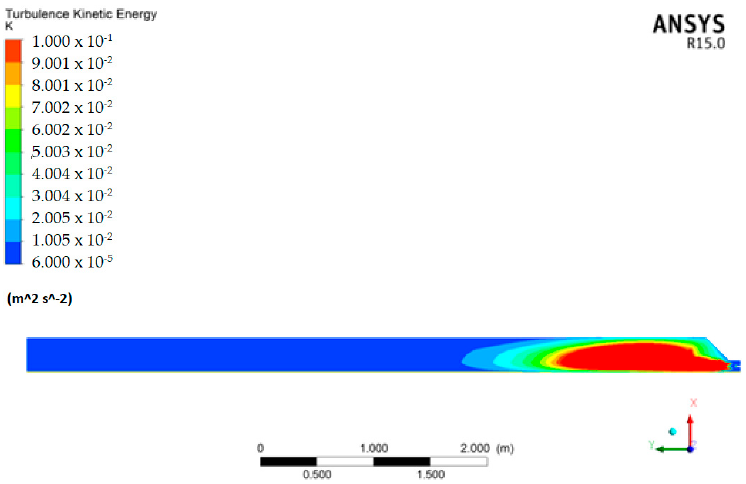
Figure 4. Turbulent kinetic energy distribution in the median section of the pipeline.